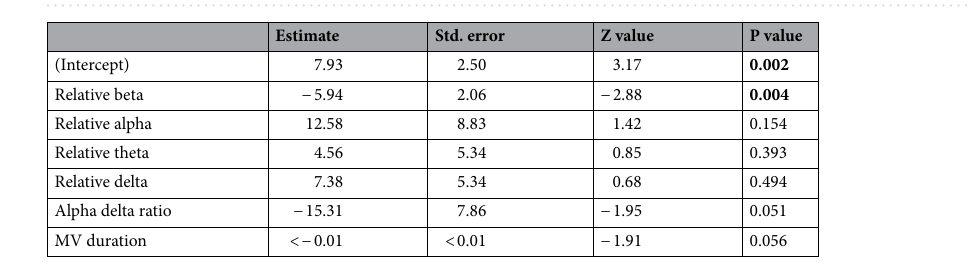
Table 3. Power value fluctuations in patients with successful extubation (SE) versus extubation failure (FE); logistic regression considering coefficients of variation (CV) over all channels. MV = mechanical ventilation, Std. error = standard error. Significant values are in